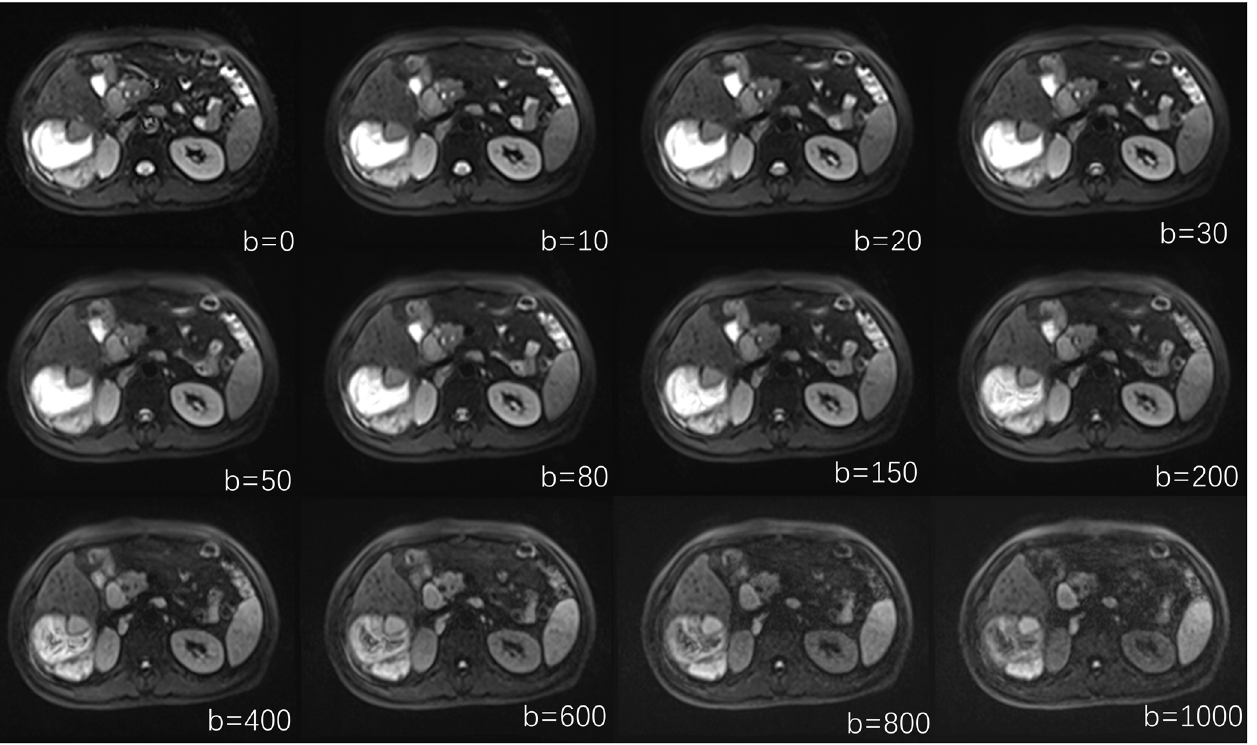
Figure 3. IVIM images at different b values. IVIM ‐ DWI images with 12 b ‐ values, representing b values of 0, 10, 20, 30, 50, 80, 150, 200, 400, 600, 800, and 1000 s/mm 2 .